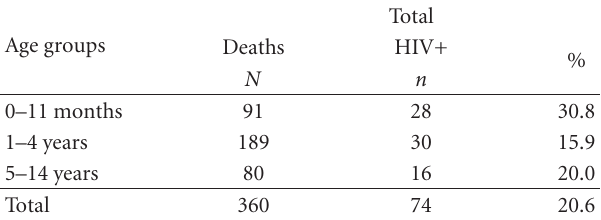
Table 2: HIV infection rate according to the age of the deceased